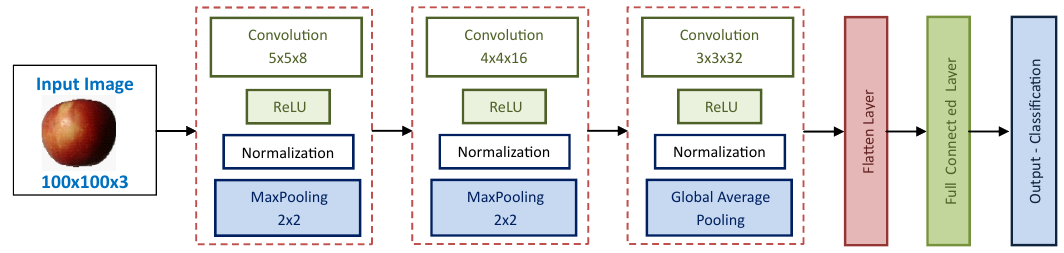
Figure 10. Designed CNN architecture for fruit